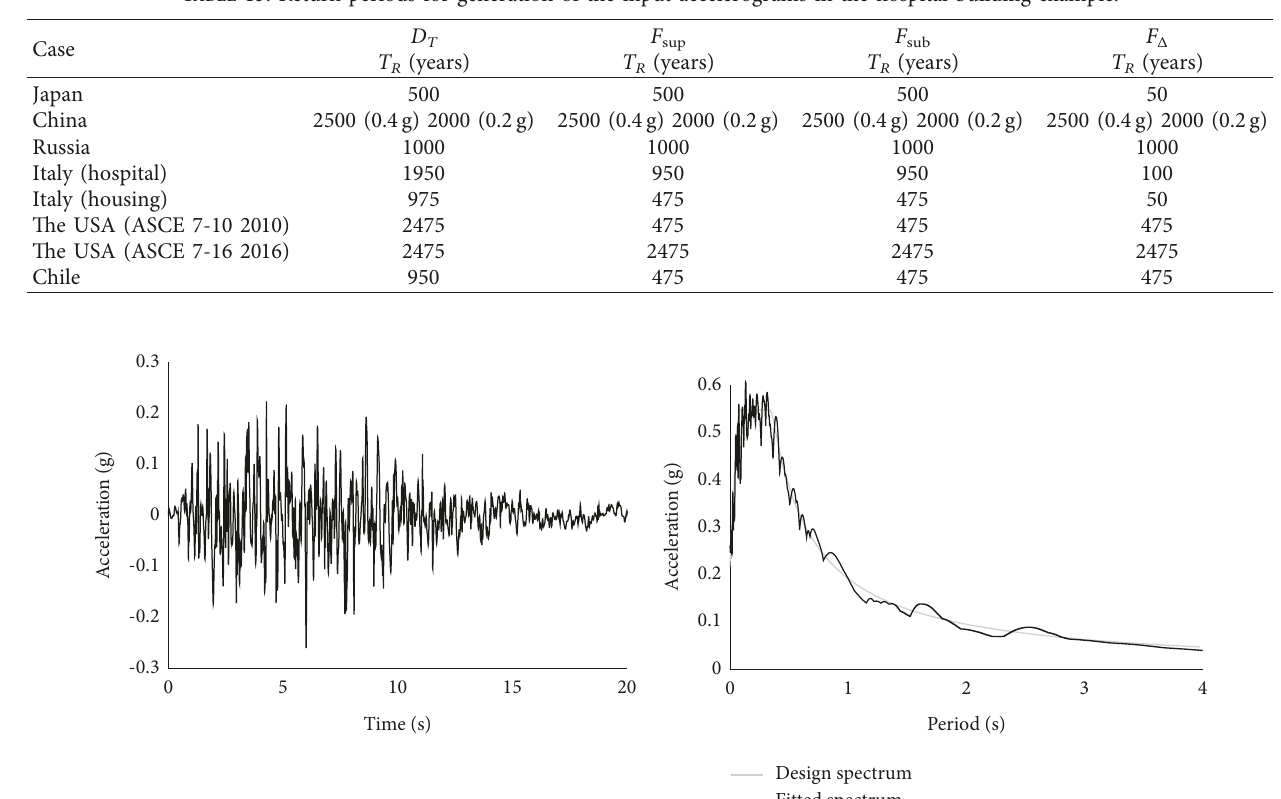
Table 15: Return periods for generation of the input accelerograms in the hospital building example.